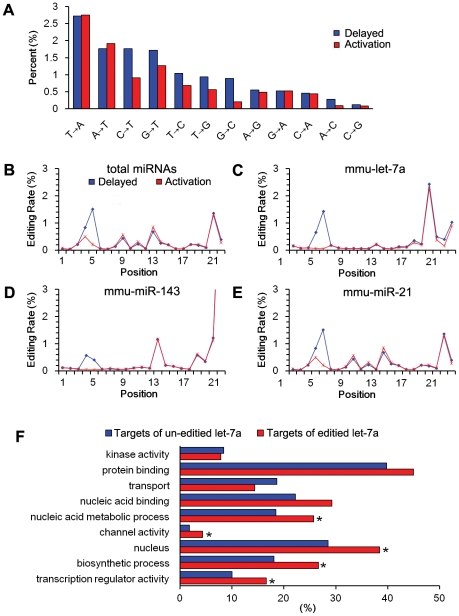
miRNA editing.(A)The percentages of various edited forms in all of the miRNAs. The editing rate of each position of the total miRNAs (B), let-7a (C), miR-143 (D) and miR-21 (E) in mouse uteri from delayed implantation and activation are shown. (F) Gene ontology analysis of the targets of unedited and edited let-7a. The “biological process” of the target mRNAs is compared between two groups. A p value is assigned to each GO term by chi-square test.